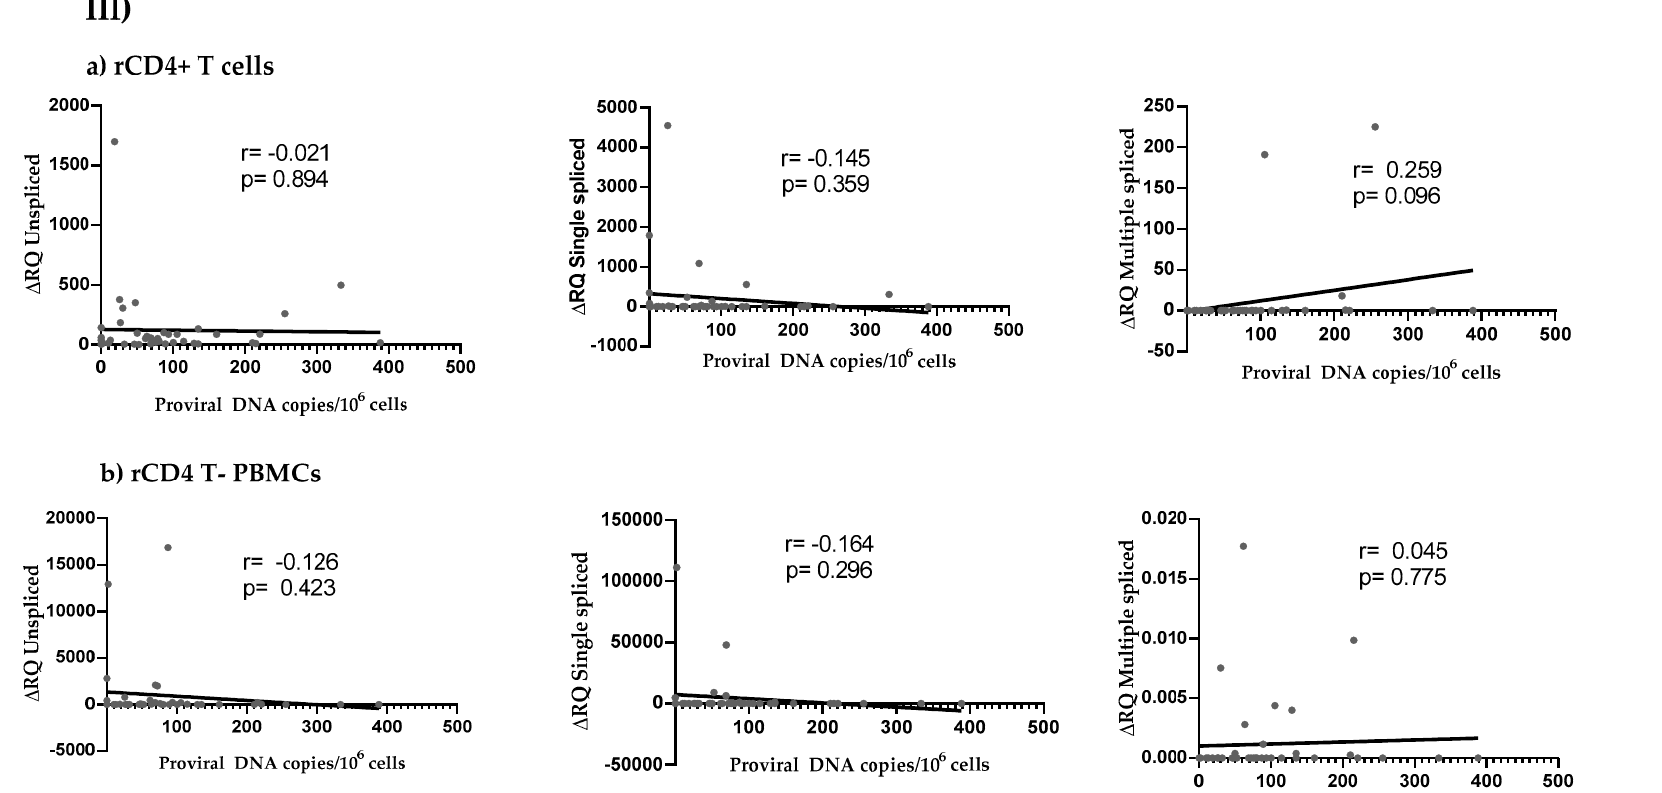
Figure 3. Correlations between HIV reservoir size and different forms of HIV splicing in ( a ) rCD4+ T cells and ( b ) rCD4 T- PBMCs according to the study population: ( I ) HIV+ group, ( II ) HIV +/HCV − group, and ( III ) HIV +/HCV+ group.